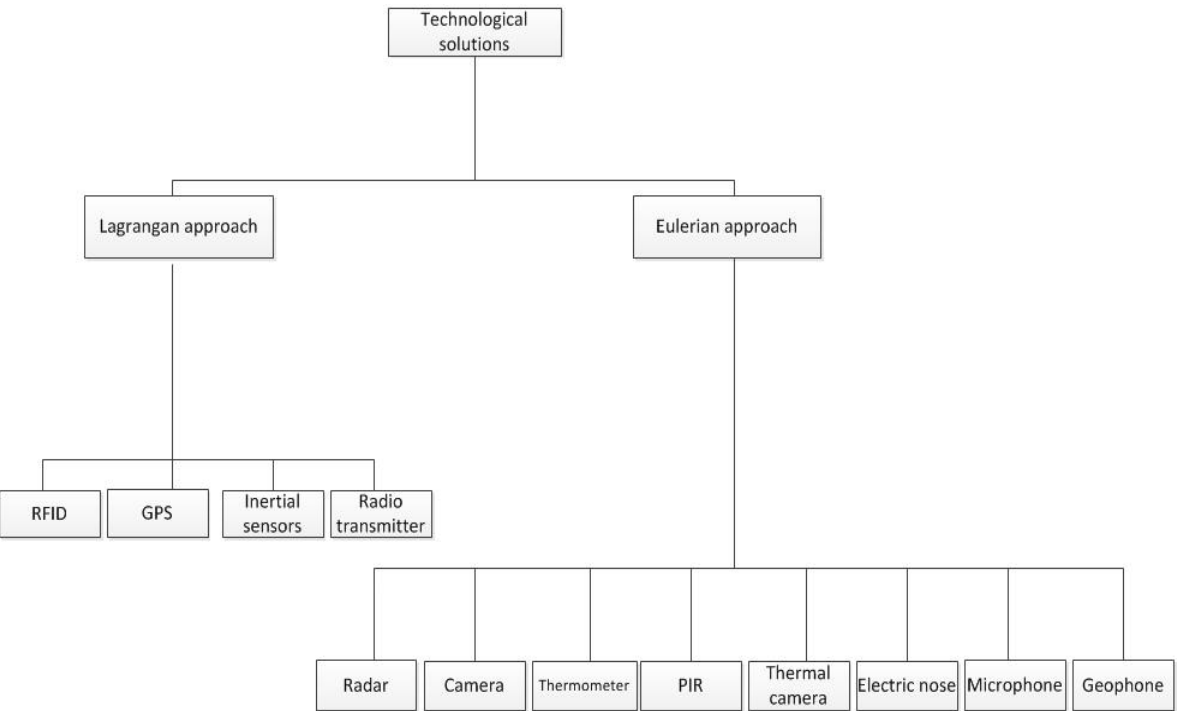
Figure 1. Taxonomy of the technologies used for collecting spatio-temporal data for ecological movement